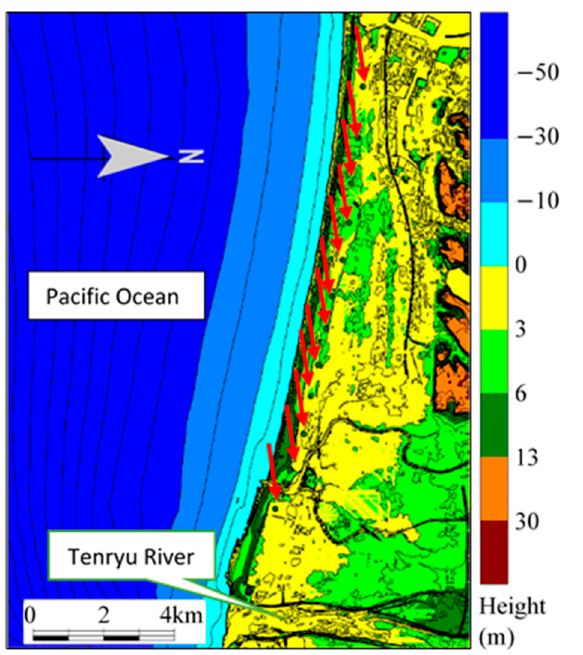
Figure 11. Topography map and calculation range of the Hamamatsu Coast.